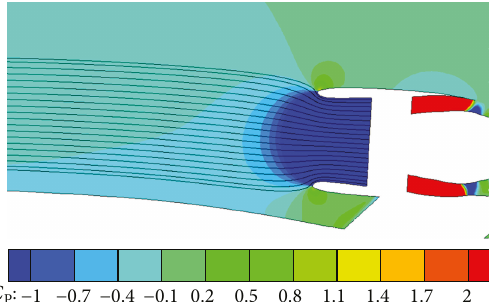
Figure 21: In fl ow streamlines of the engine on its symmetry plane at 9 ° (low speed).